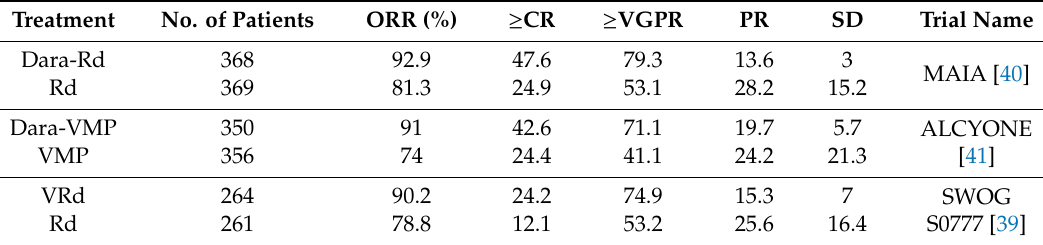
Table 2. Randomized trials of induction therapies in ASCT-ineligible patients.